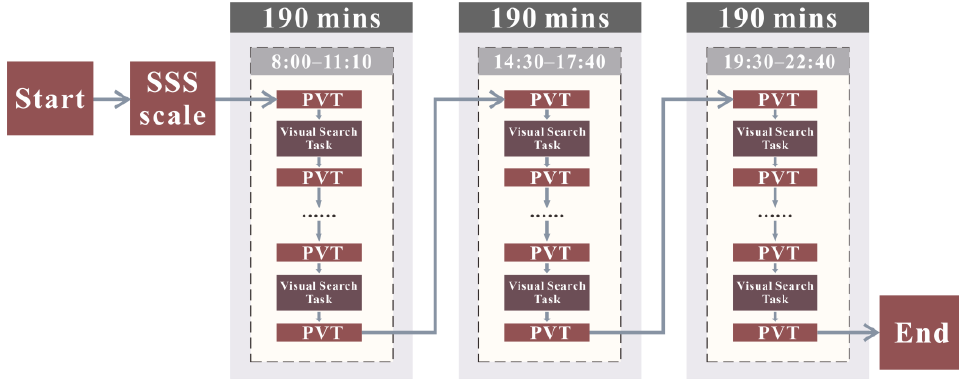
Figure 4. Flowchart of the assessment.